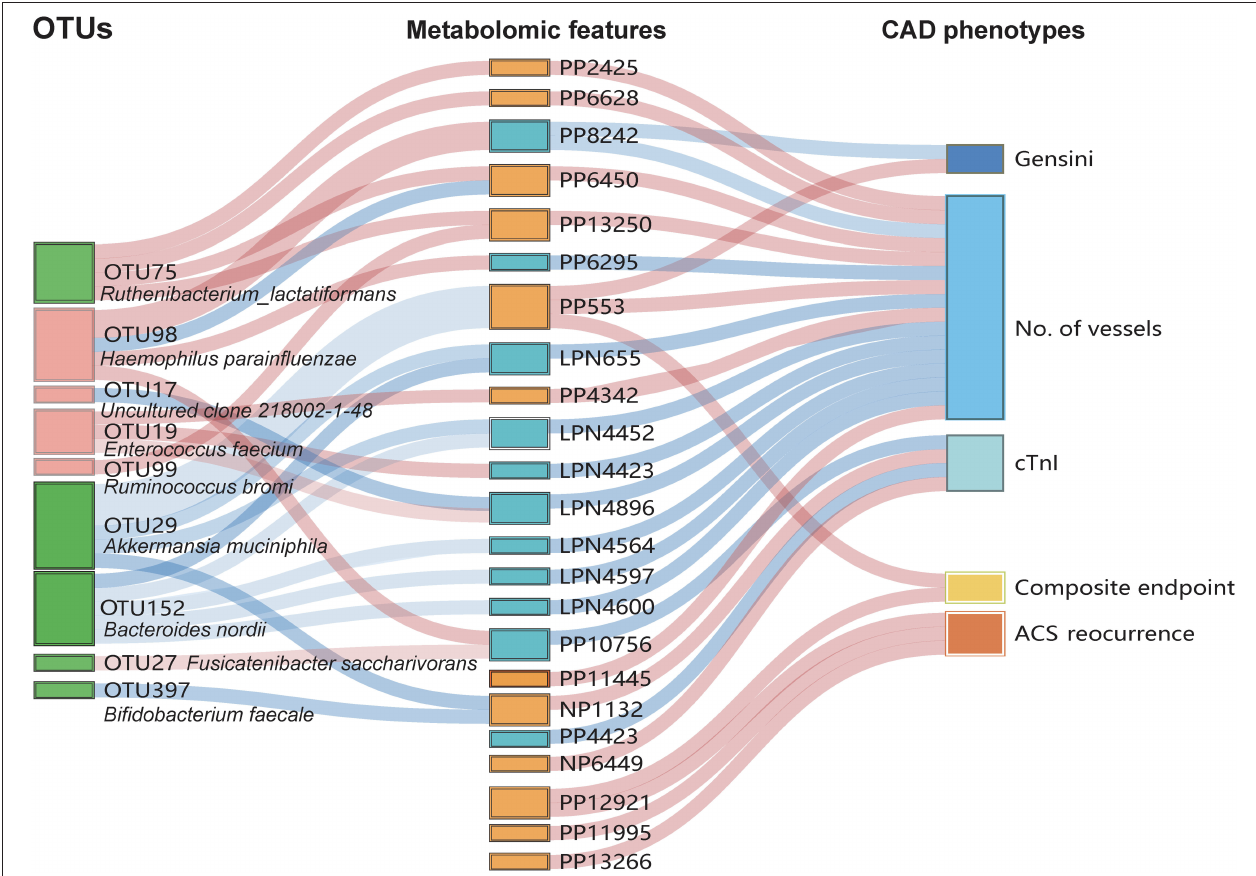
FIGURE 5 | Interrelationship among smoking-associated gut flora, serum metabolic features, and major CAD phenotypes. A Sankey plot was utilized to examine and visualize the correlation between important smoking-associated OTUs and the severity and outcomes of CAD in the mediation of key serum metabolic features. Connections in red indicate positive correlations while blue connections indicate negative correlations (Spearman correlation analysis, p < 0.05). In the left column, red boxes indicate smoking-positive OTUs, and green boxes indicate smoking-negative OTUs. In the metabolic features column, orange boxes indicate smoking-positive metabolic features and blue boxes indicate smoking-negative metabolic features. A composite endpoint was defined as all-cause mortality and/or reoccurrence of ACS and/or readmission for cardiac causes. No. of vessels: ANthe number of stenosed vessels; cTnI: cardiac troponin